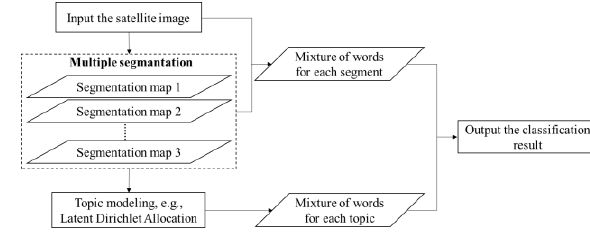
Figure 3 The proposed topic modelling algorithm based on multiscale segmentation